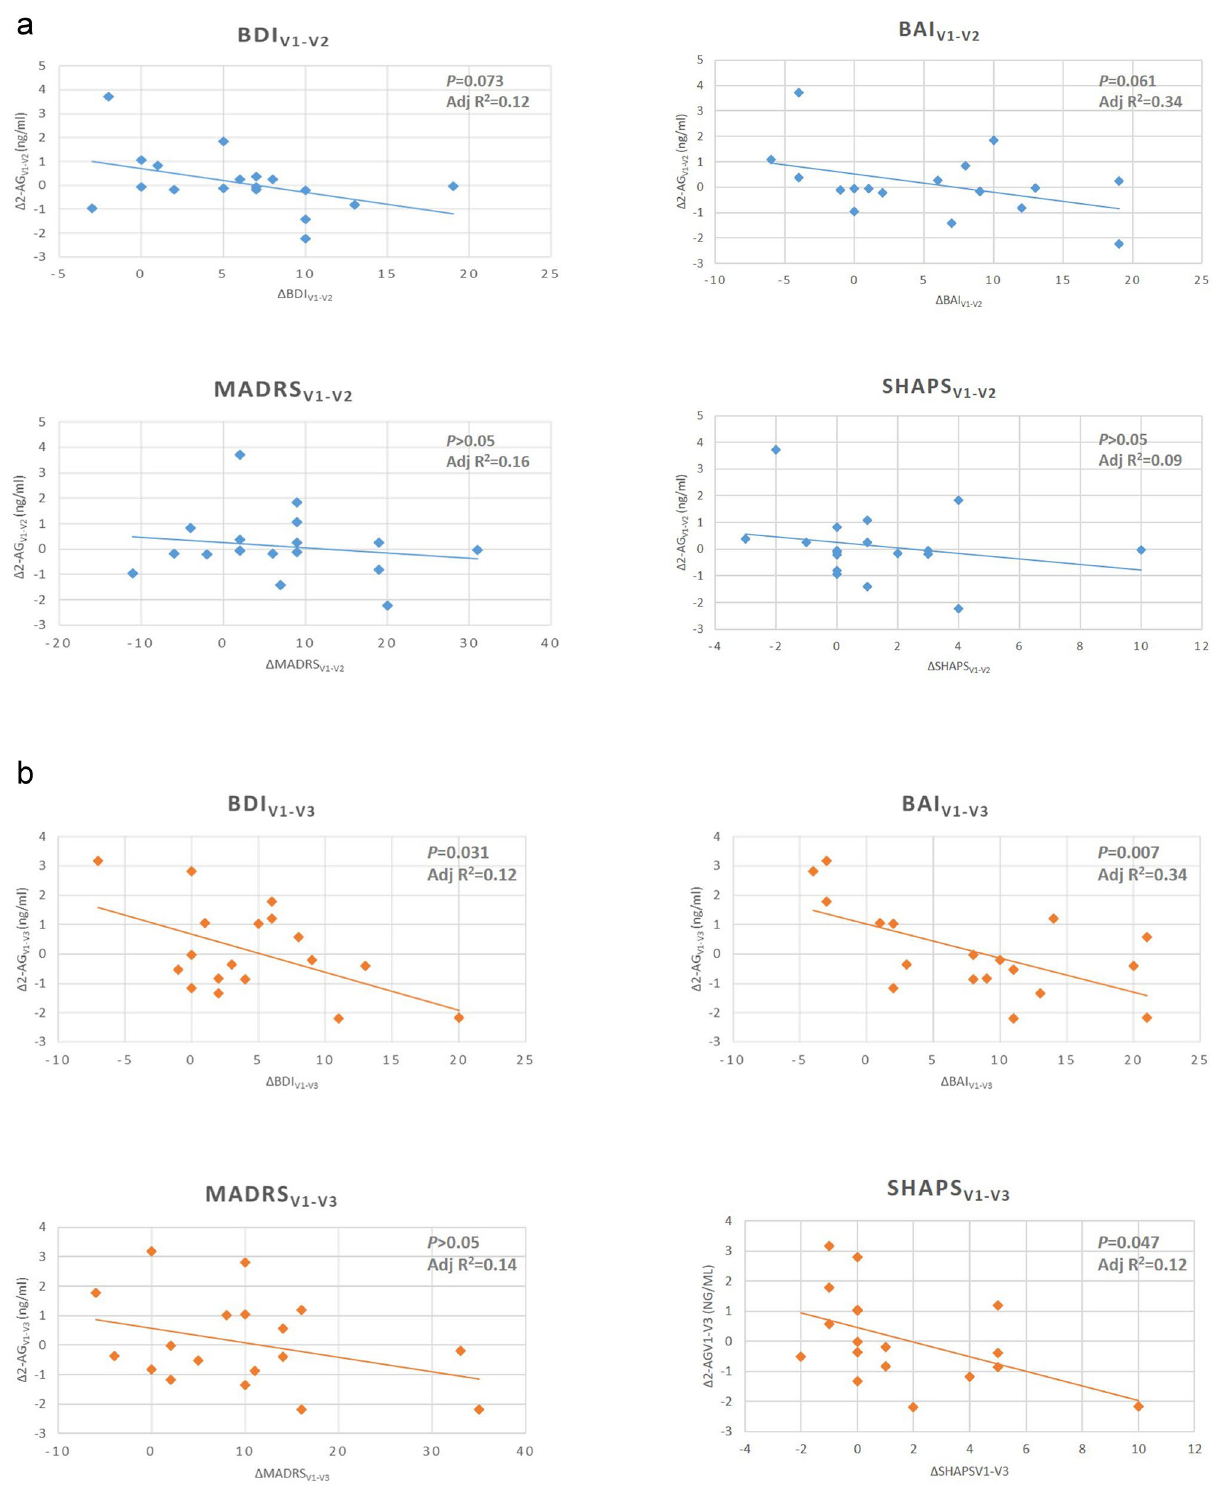
Figure 2. a Regression analyses of serum eCB differences and symptom score alterations between v 1 and v 2 . Differences between V1 and V2 visits are presented (Δ values) in case of 2-AG levels (y axis) and symptom scores (x axis). b Regression analyses of serum eCB differences and symptom score alterations between v 1 and v 3 . Differences between V1 and V2 visits are presented (Δ values) in case of eCB levels (y axis) and symptom scores (x axis). BDI Beck Depression Inventory, MADRS Montgomery-Asberg Depression Scale, BAI Beck Anxiety Inventory, SHAPS Snaith–Hamilton Pleasure Scale; 2-AG 2-arachidonoylglycerol, AEA